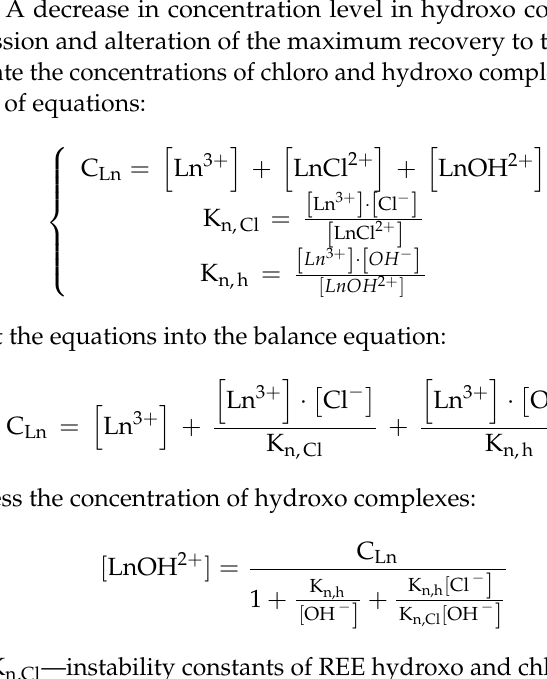
Table 5. The yttrium (III) and lanthanum (III) hydroxo and chloro complexes instability constants. Compound K n,Cl ∆ compl G 0 , kJ/moL Compound K n,h ∆ compl G 0 298 LaCl 2+ 0.077 − 6.34 La(OH) 2+ 1.70 × 10 − 8 − 44.35 YCl 2+ 0.054 − 7.22 Y(OH) 2+ 1.56 × 10 − 8 −